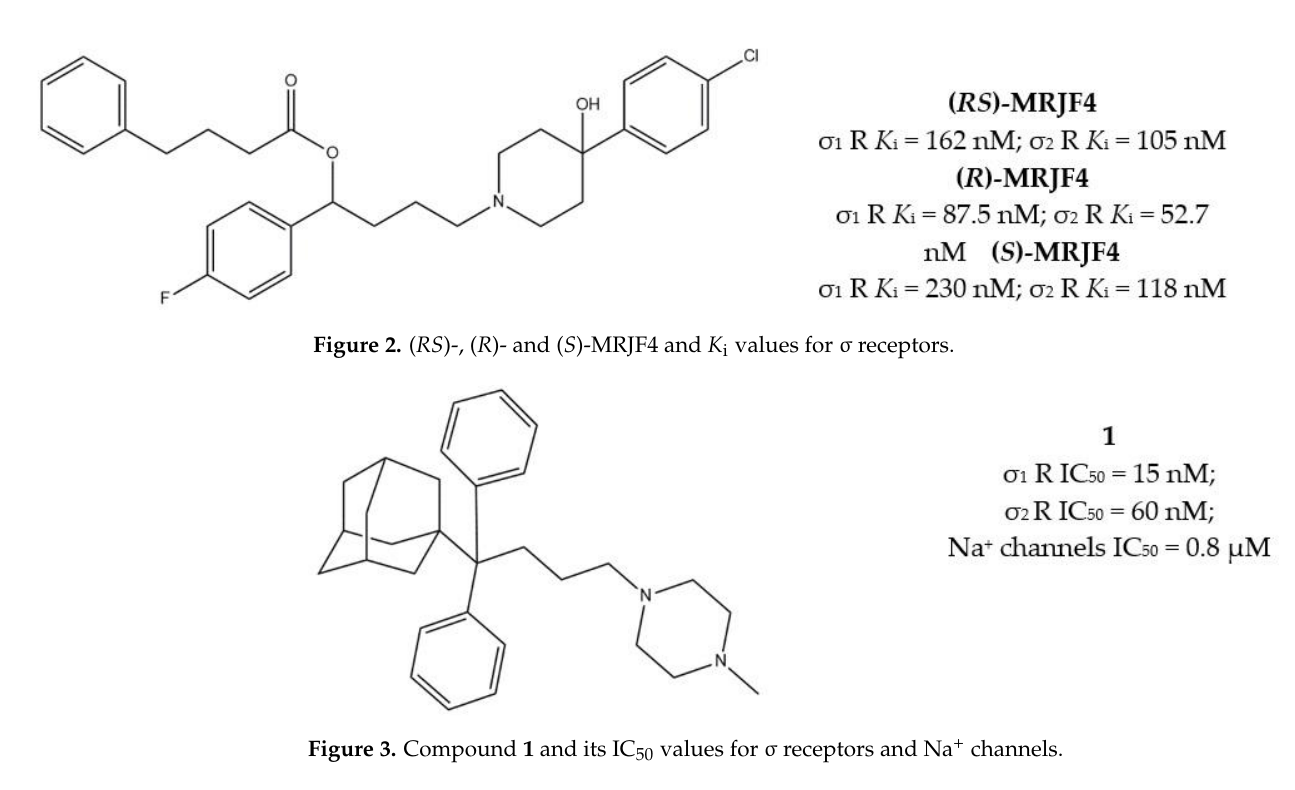
Figure 3. Compound 1 and its IC 50 values for σ receptors and Na + channels.